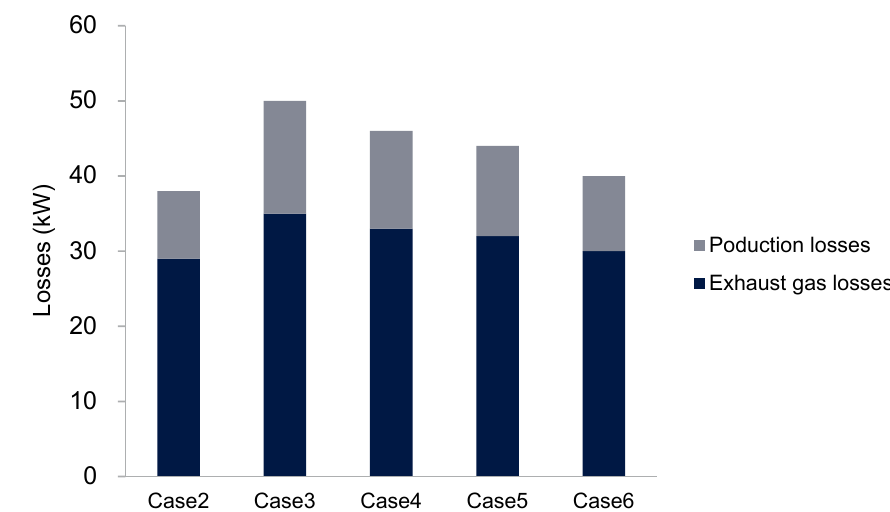
Figure 10. Exhaust and operational furnace losses for all the studied cases.